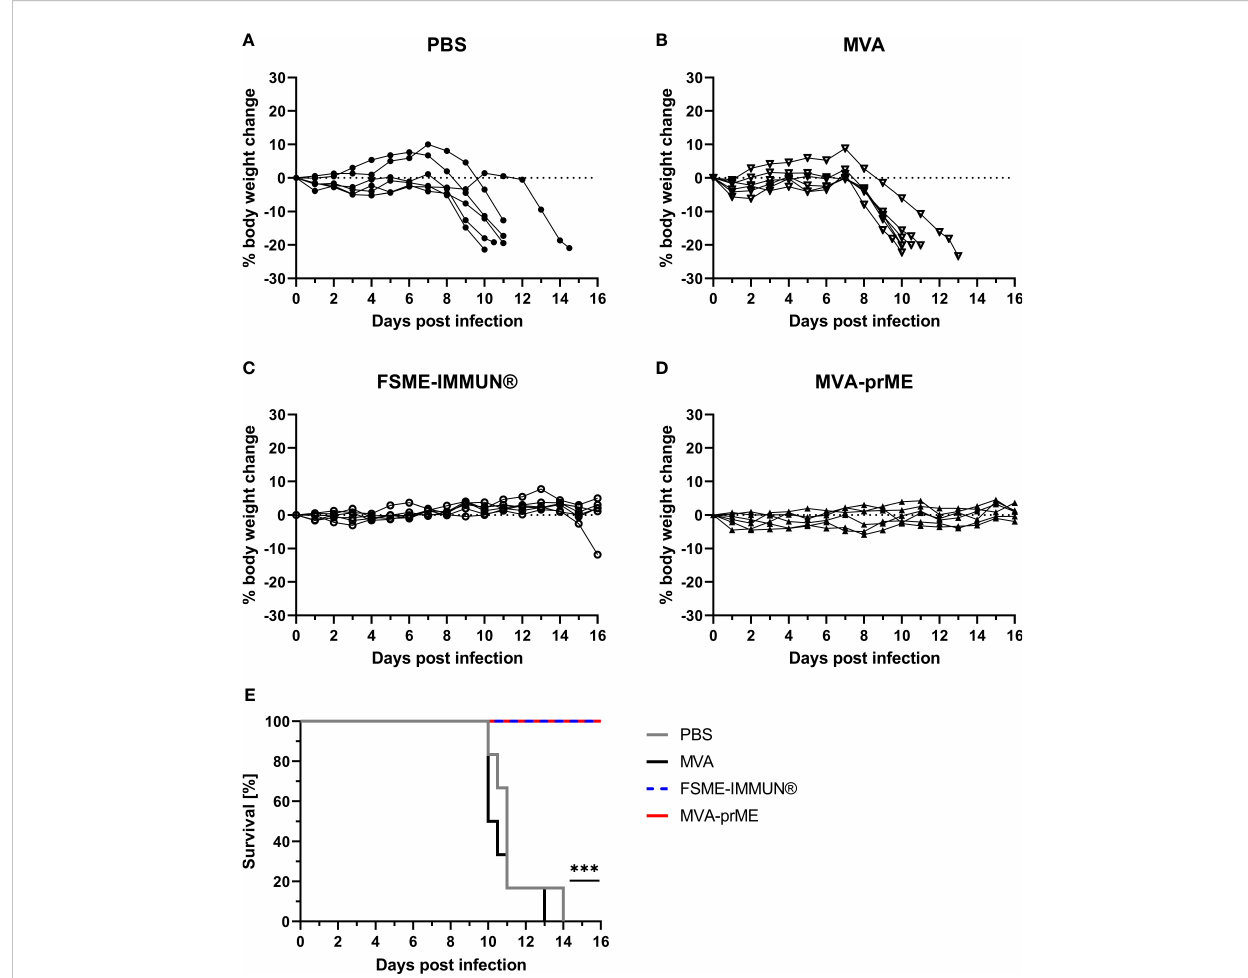
FIGURE 3 Body weight change and survival curves of vaccinated and challenge infected mice. (A – D) Percentage of body weight change compared with initial body weight on the day of challenge during the entire course of TBEV infection for PBS- (A) , MVA- (B) , FSME-IMMUN ® - (C) , and MVA-prME- vaccinated (D) mice. (E) Kaplan – Meier curves showing the percentage of survival of mice vaccinated with PBS (gray), MVA (black), FSME-IMMUN ® (blue, dotted), or MVA-prME (red) (n = 6, *** p ≤ 0.001). p = 0.0007: FSME-IMMUN ® /MVA-prME versus PBS, p = 0.0004: FSME-IMMUN ® /MVA-prME versus